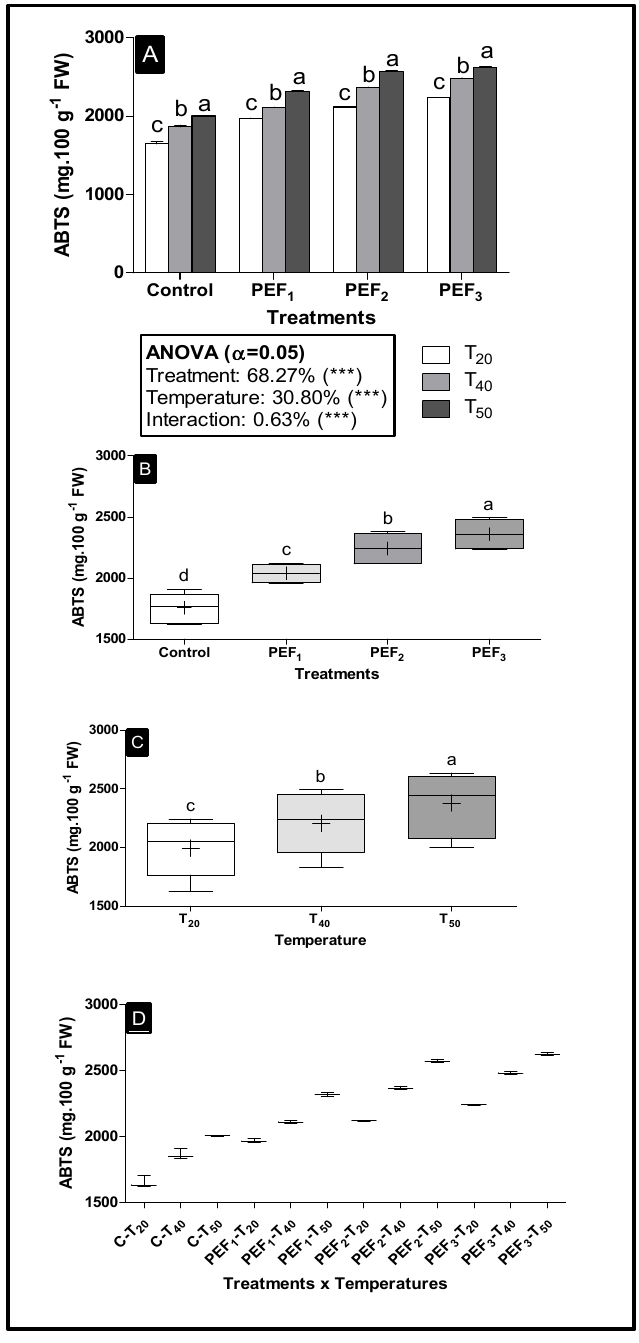
Figure 6. Antioxidant activity (ABTS assay) of the results obtained from untreated and different PEF-treated extracts. The tests were performed as triplicates and values are mean ± standard devia- tion. Different superscript alphabets in a row show significant difference ( p < 0.05) using Duncan’s multiple-range test.